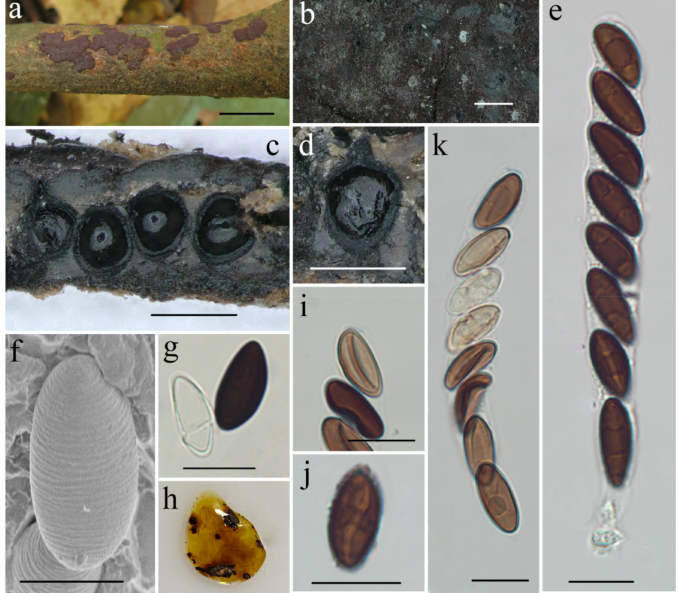
Figure 3. Hypoxylon cyclobalanopsidis (holotype FCATAS 2714). ( a ) Stromata on branches. ( b ) Stromatal surface and ostioles. ( c , d ) Stroma in vertical section showing the perithecia and tissue below the perithecial layer. ( e ) Mature ascus in water showing germ slit. ( f ) Ascospore under SEM. ( g ) Ascospore in 10% KOH. ( h ) KOH-extractable pigments. ( i ) Apical apparatus in Melzer’s reagent. ( j ) Ascospore in water showing germ slit. ( k ) Ascus in Melzer’s reagent. Scale bars: ( a ) = 1cm; ( b – d ) = 200 µ m; ( e , g , i – k ) = 10 µ m; ( f ) = 5 µ